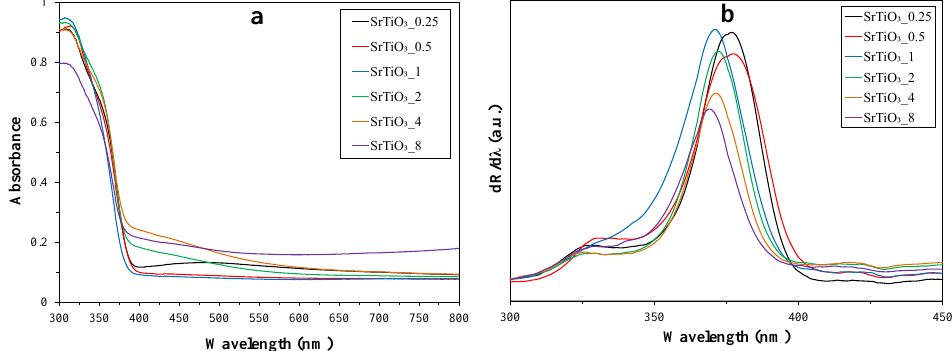
Figure 2. DR ( a ) absorbance and ( b ) first order derivative spectra of SrTiO 3 photocatalysts prepared at various EG:H 2 O ratios.